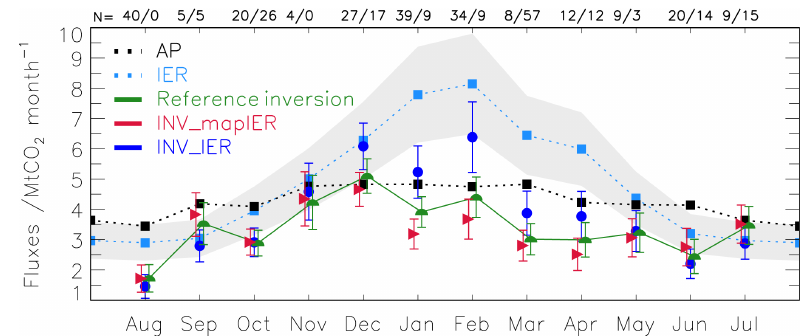
Figure 7. Sensitivity of monthly fossil fuel CO 2 emissions on H map . Red: monthly fossil fuel CO 2 emission estimates ± the standard deviation of their uncertainties obtained from the reference inversion (green), INV_mapIER (red), and INV_IER (blue), respectively. Monthly fossil fuel CO 2 emissions prior estimates by AIRPARIF (black) and IER’s monthly estimates (light blue) ± the standard deviation of uncertainties (shaded grey area). Note the different scale of the ordinate compared to Figs. 3, 5 and